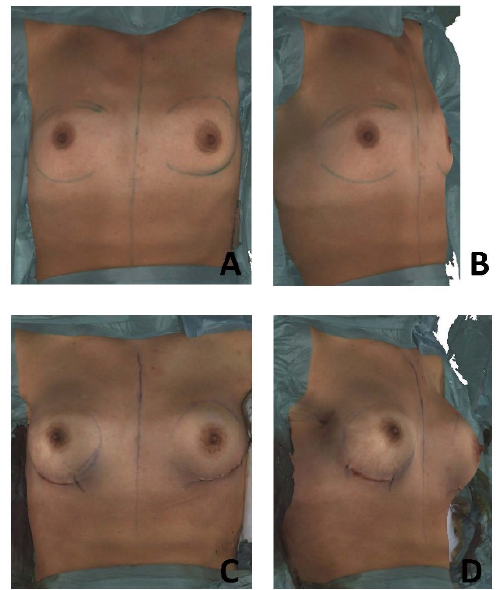
Figure 2. Preoperative 3D Surface Image in operating room (O.R., frontal ( A ); oblique view ( B )) and postoperative 3D Surface Image in O.R. after implant insertion (frontal ( C ); oblique ( D )).